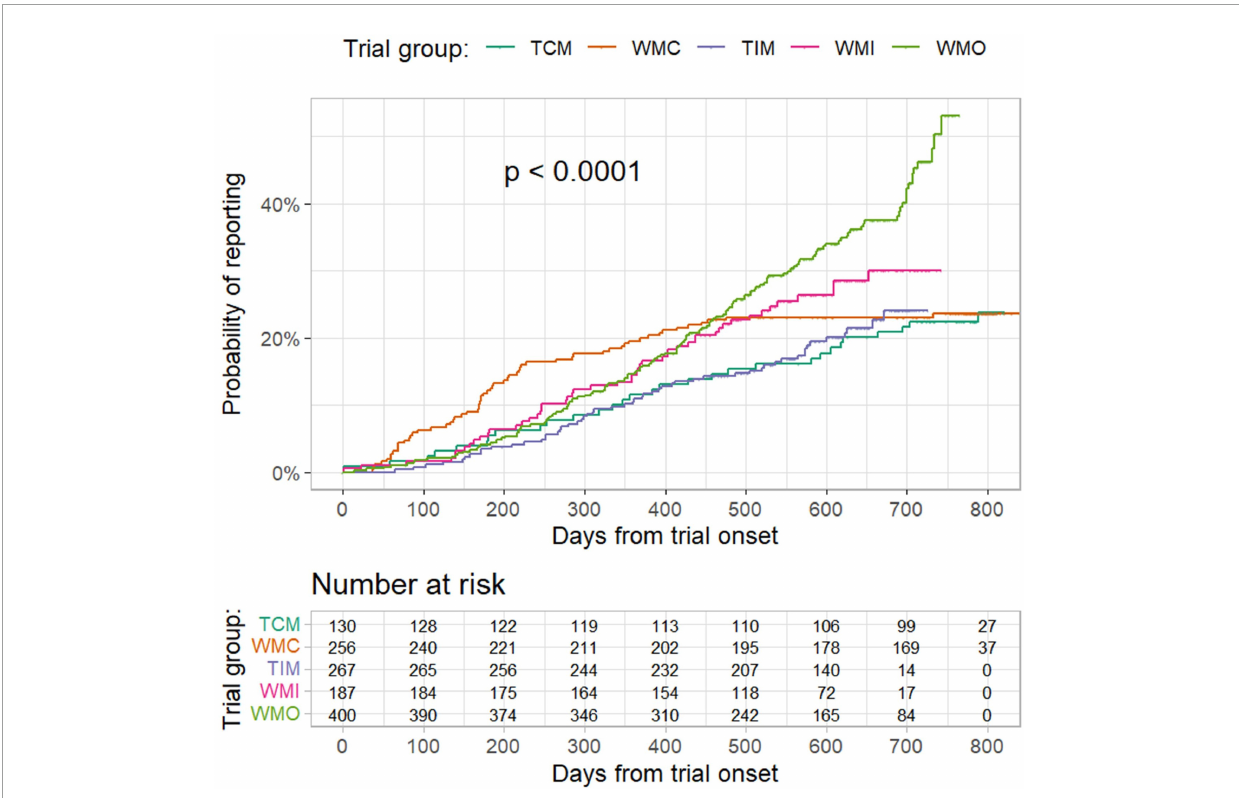
FIGURE2 Probability of result reporting from trial onset to 20 April 2022 by different trial groups. TCM refers to “traditional Chinese medicine”; WMC refers to “trials of conventional medicine in China”; TIM refers to “trials of traditional Indian medicine”; WMI refers to “trials of conventional medicine in India”; and WMO refers to “trials conducted in other countries”. P values were from log-rank test.